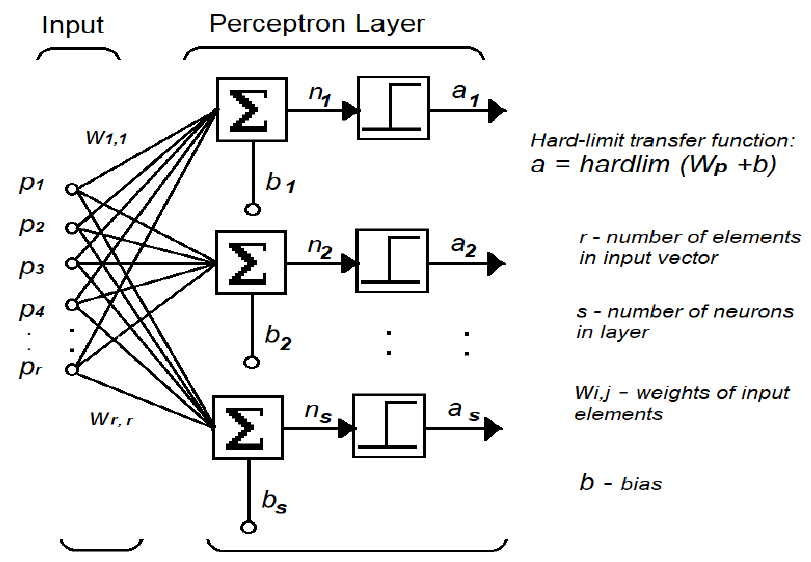
Figure 2. The perceptron neural network architecture. Inputs p1, p2 . . . pr are the hyperspectral signatures from one dataset.